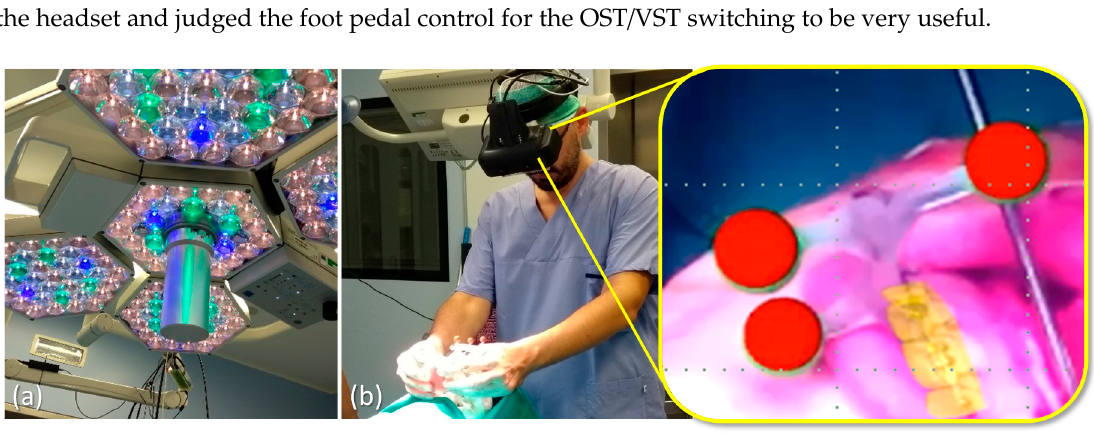
Figure 7. Results obtained under scialitic lamp lighting conditions ( a ) for the tracking and registration using the ad hoc maxilla tracker: red virtual spheres precisely overlaid to the real green ones as seen through the visor ( b ).